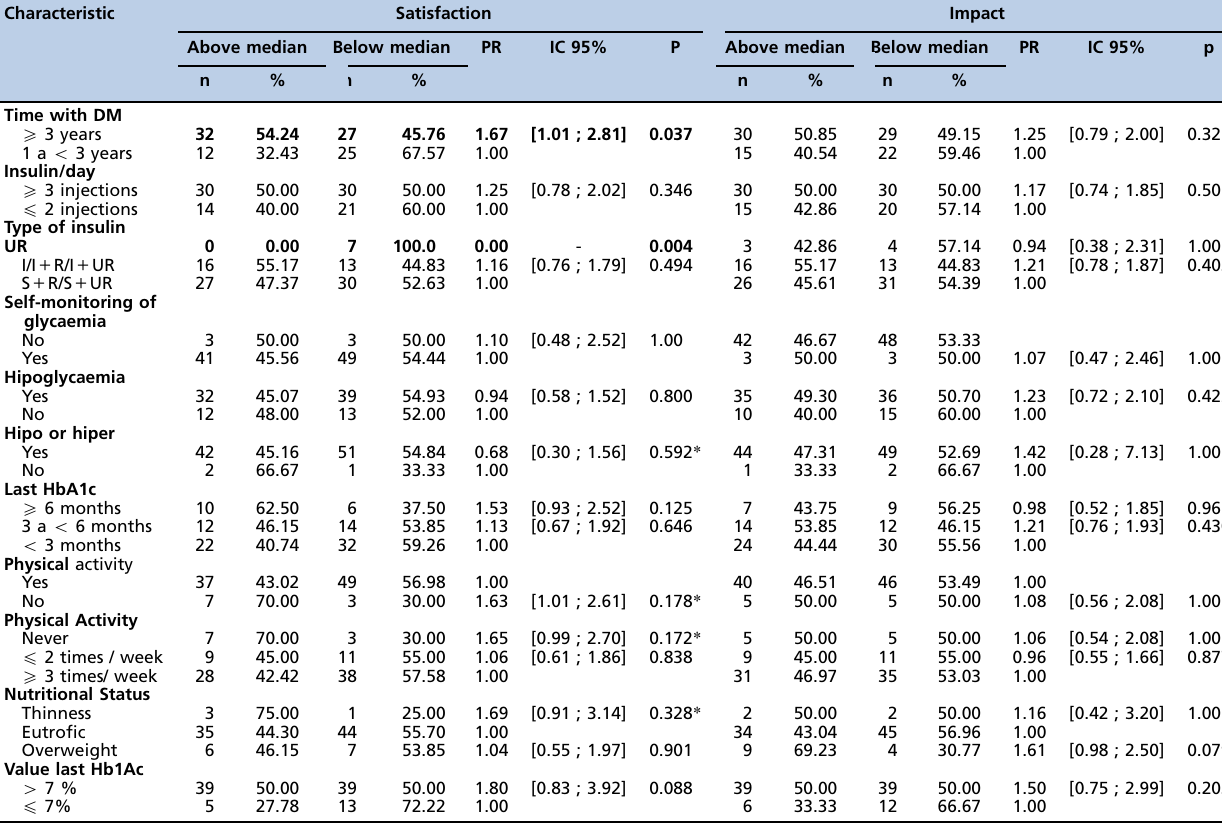
Table 1, Line 28: where it reads ‘‘ R ’’ it should read ‘‘ S ’’ . Table 1, Line 42: where it reads ‘‘ 30.21 ’’ it should read ‘‘ 69.79 ’’ . Table 1, Line 44: where it reads ‘‘ 69.79 ’’ it should read ‘‘ 30.21 ’’ . Table 1, Line 45: where it reads ‘‘ 71.88 ’’ it should read ‘‘ 28.13 ’’ . Table 1, Line 46: where it reads ‘‘ 28.13 ’’ it should read ‘‘ 71.88 ’’ . In the same article, on page 177, Table 3A should read